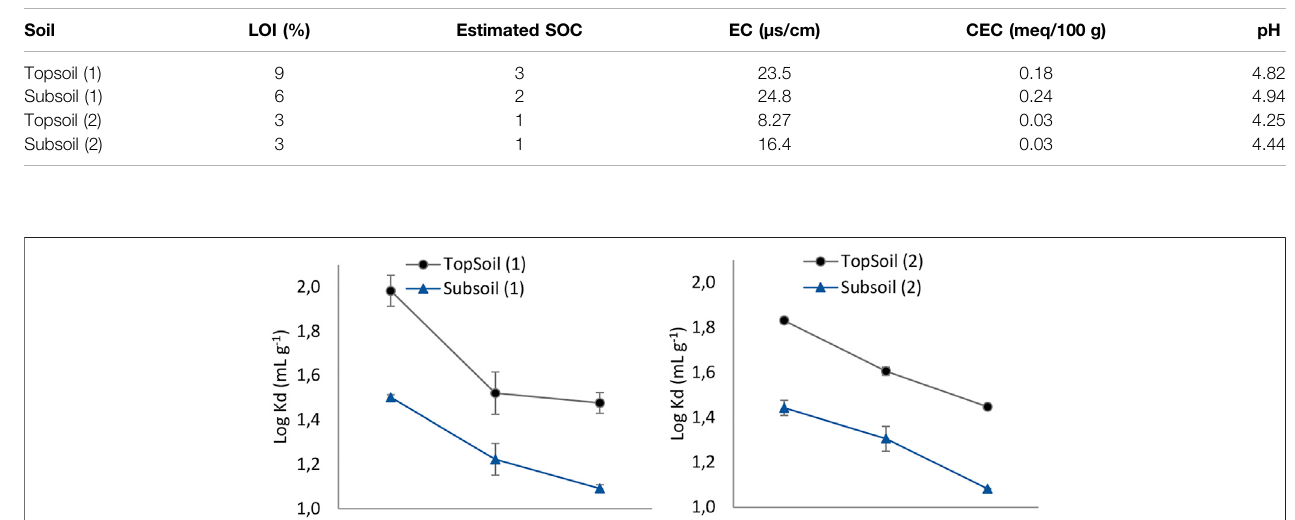
Frontiers in Environmental Chemistry |